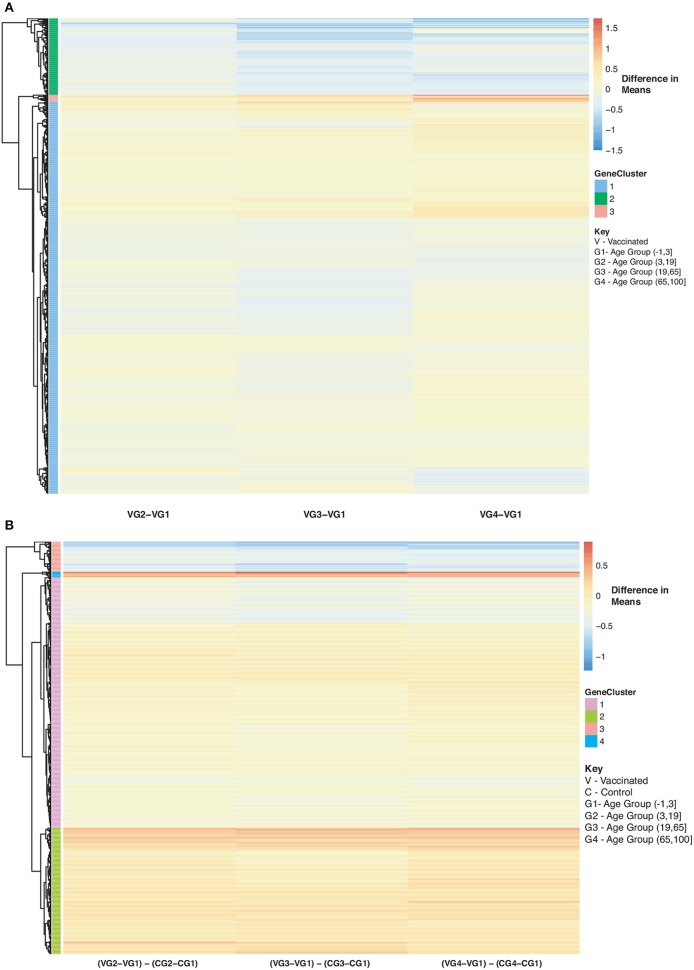
Heatmap of Statistically Significant (Bonferroni-adjusted p < 0.05) Genes with an Interaction Between Disease State and Age for Influenza Vaccinated Subjects. (A) Difference in means calculated by comparing influenza vaccinated subjects in age groups 2–4 to influenza vaccinated subjects in age group 1 (baseline). (B) Comparison of influenza vaccinated subjects to control subjects in the different age groups by calculating the difference between the baseline-adjusted means for influenza vaccinated subjects (A) and control subjects (Figure 8).